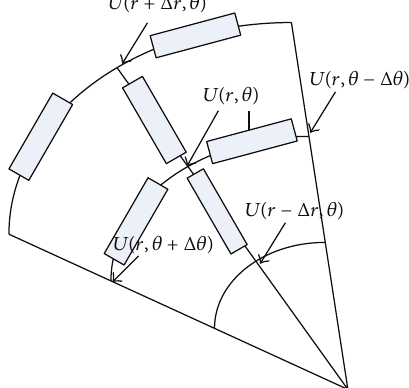
Figure 2: The polar grid of the resistive